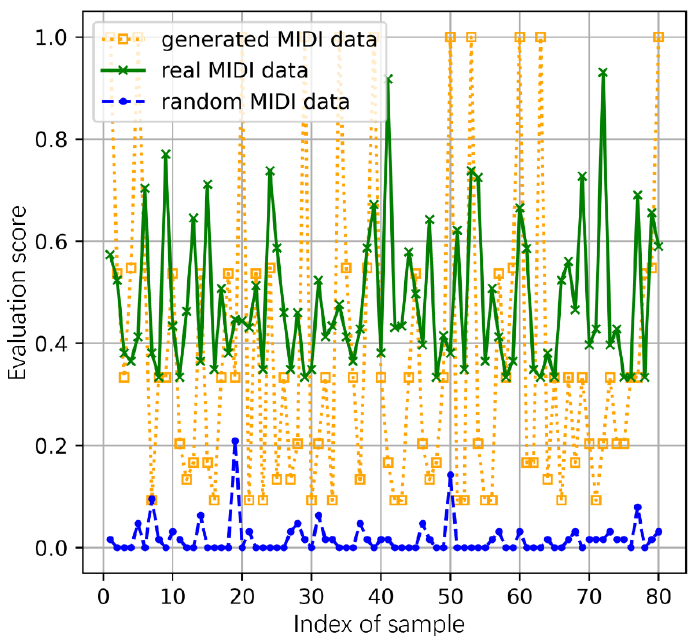
Figure 14. Evaluation scores of BLEU using real MIDI data, generated MIDI data, and random MIDI data.